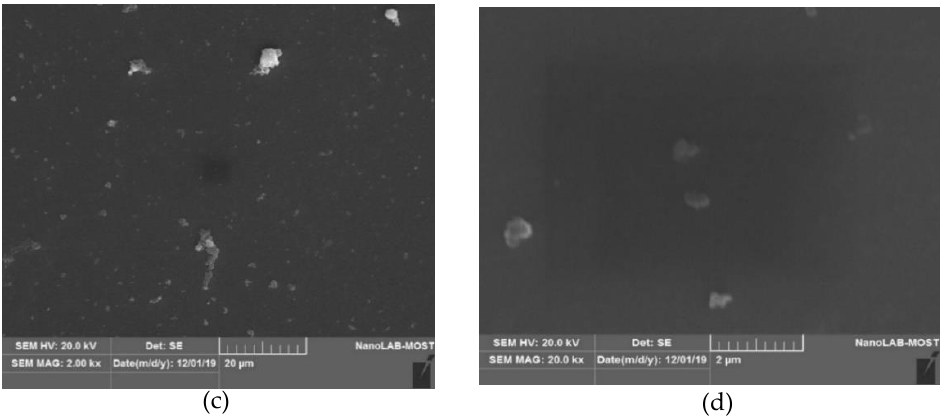
Figure 4. SEM images of the HL particles at 2K × . ( a ) r-HL, ( b ) sn-HL, ( c ) n-HL and ( d ) n-HL at 20K × .